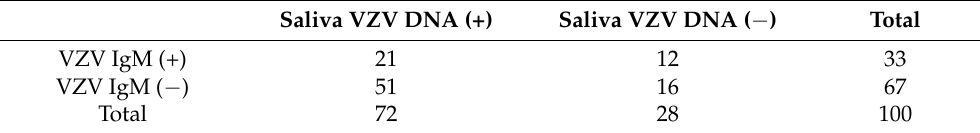
Table 2. Number of patients with RHS depending on salivary VZV DNA and serum VZV IgM.